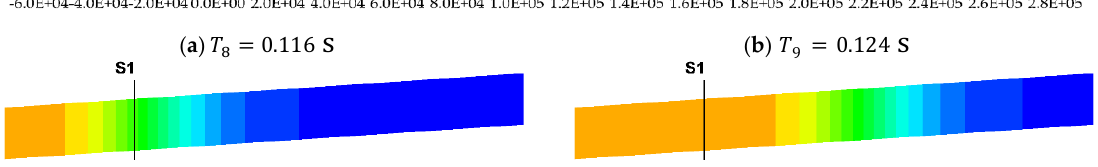
Figure 21. Pressure field evolution on the axis plane of the pipeline ( 𝑇 8 = 0.116 s and 𝑇 9 = 0.124 s ).